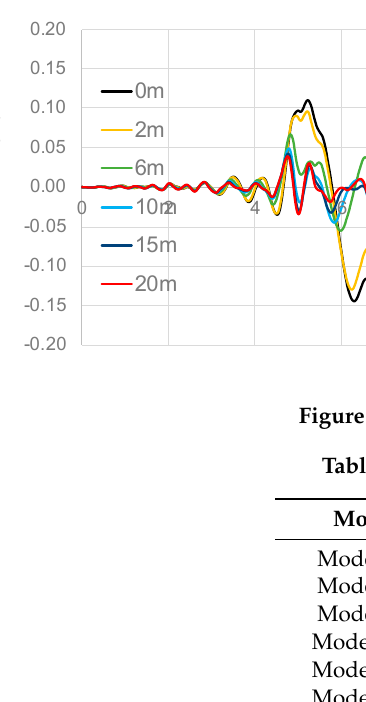
Figure 18. Model-20 m: base shear.